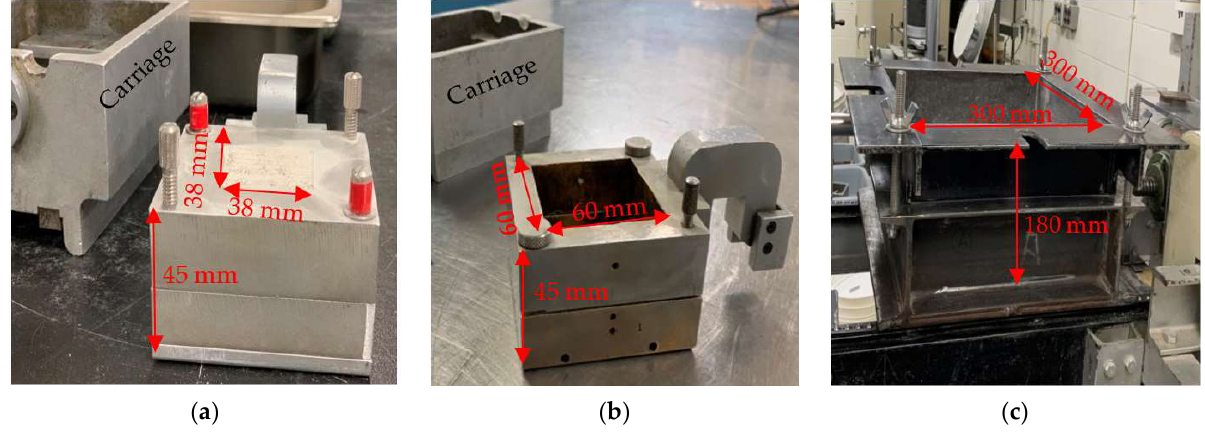
Figure 2. Shear boxes used in this study: ( a ) house-made mini square shear box (38 mm × 38 mm × 45 mm); ( b ) small (standard) square shear box (60 mm × 60 mm × 45 mm); ( c ) large square shear boxes (300 mm × 300 mm × 180 mm).